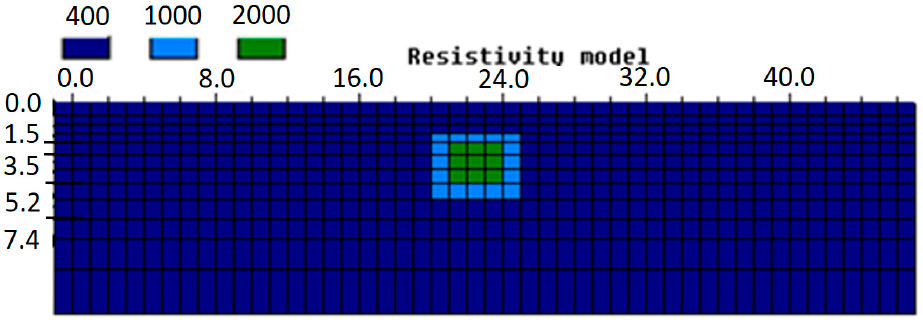
Figure 7. Numerical simulation model.